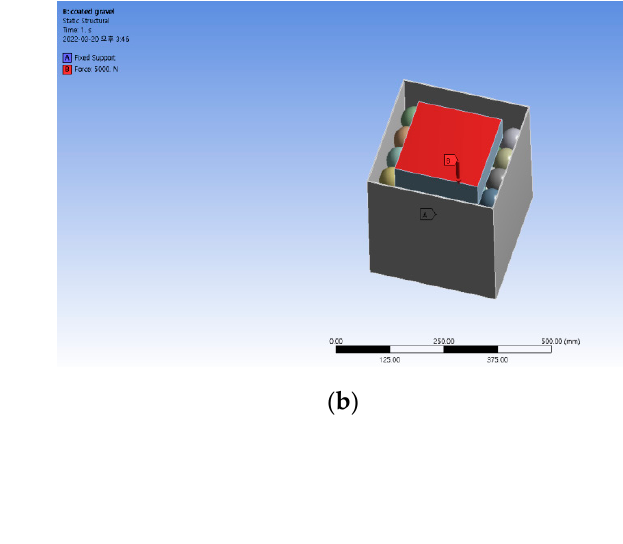
Table 1. Material and mechanical properties.